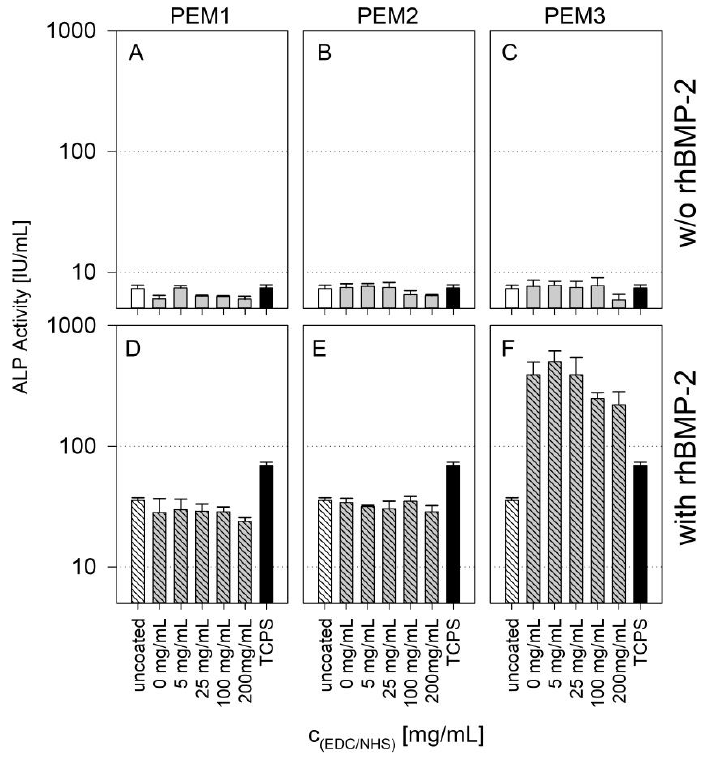
Figure 5. Results of ALP activity measurements after 7 days of cultivation in logarithmic scale; ( A – C ) without BMP-2; ( D – F ) with BMP-2. Results of a one-way ANOVA test can be found in the Appendix A in Figure A5.